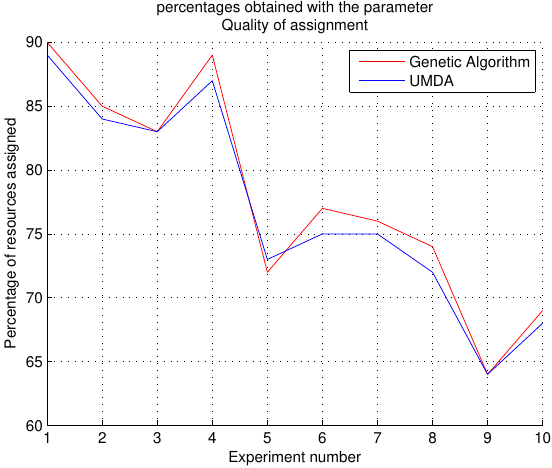
Figure 7. Results of evaluating the waiting time with parallel approach for the random generation of graphs on GPUs.